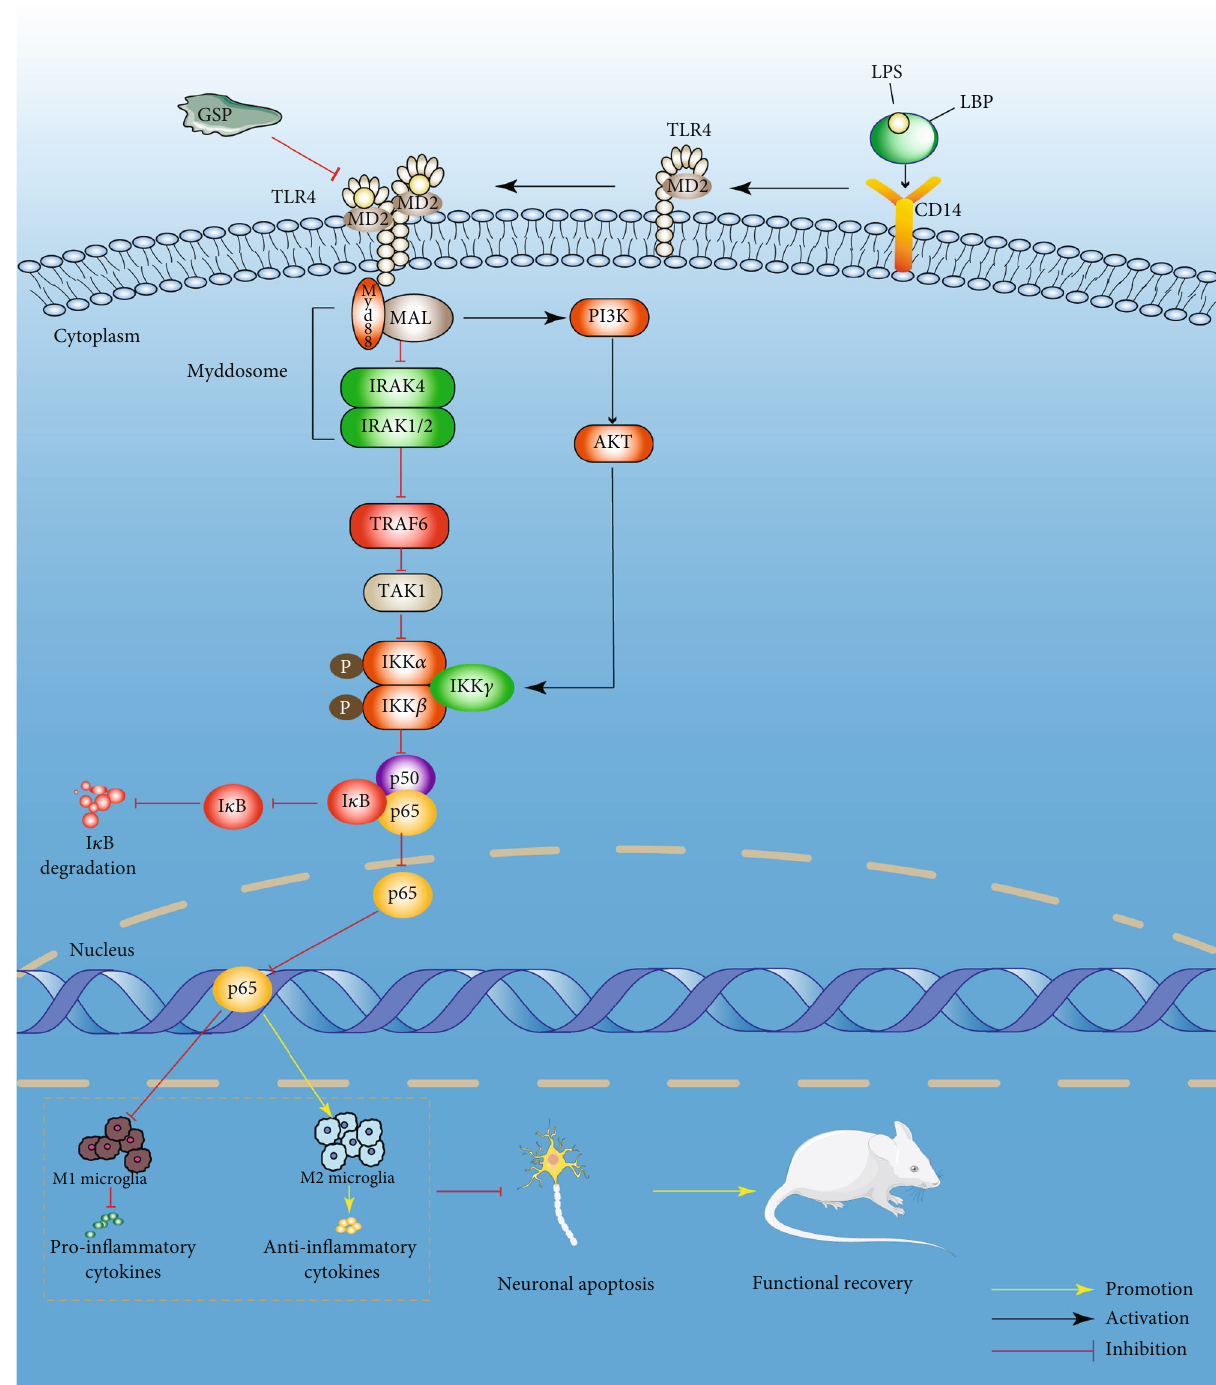
Figure 12: Schematic diagram of GSP regulate microglial polarisation through TLR4/NF- κ B/PI3K/AKT signaling